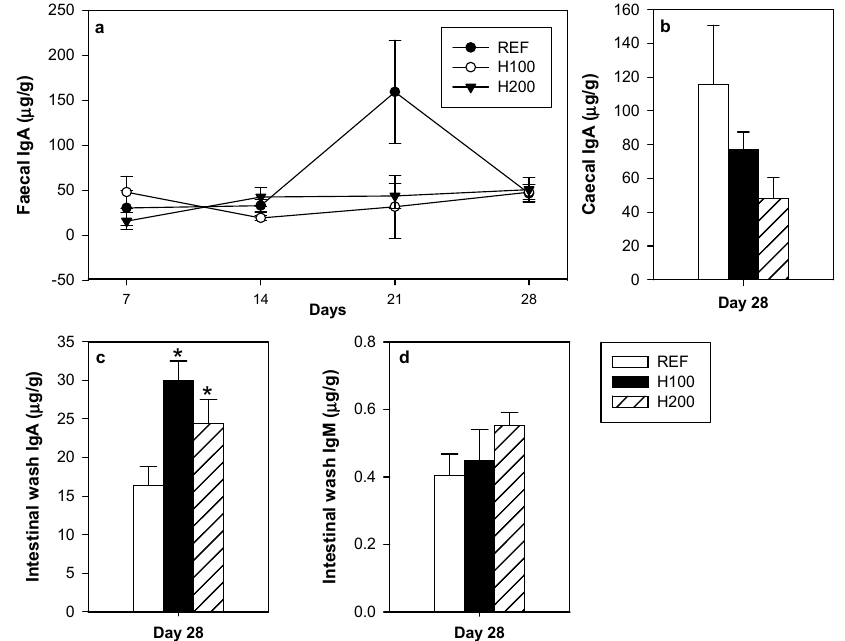
Figure 6. Effect of hesperidin administration on ( a ) IgA concentration in faeces collected throughout the study; ( b ) caecum content; ( c ) small intestine wash; and on ( d ) IgM concentration in the small intestine wash. Data are expressed as mean ± standard error ( n = 5–6). Statistical difference: * p < 0.05 versus REF group (one-way ANOVA).